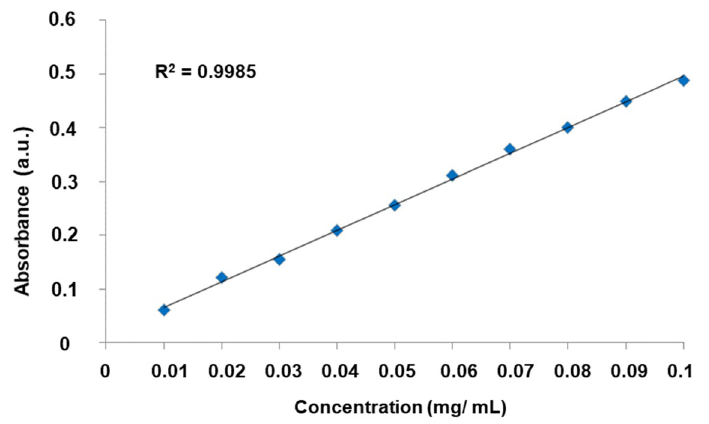
Figure 7. The standard calibration curve of L-DOPA in water.